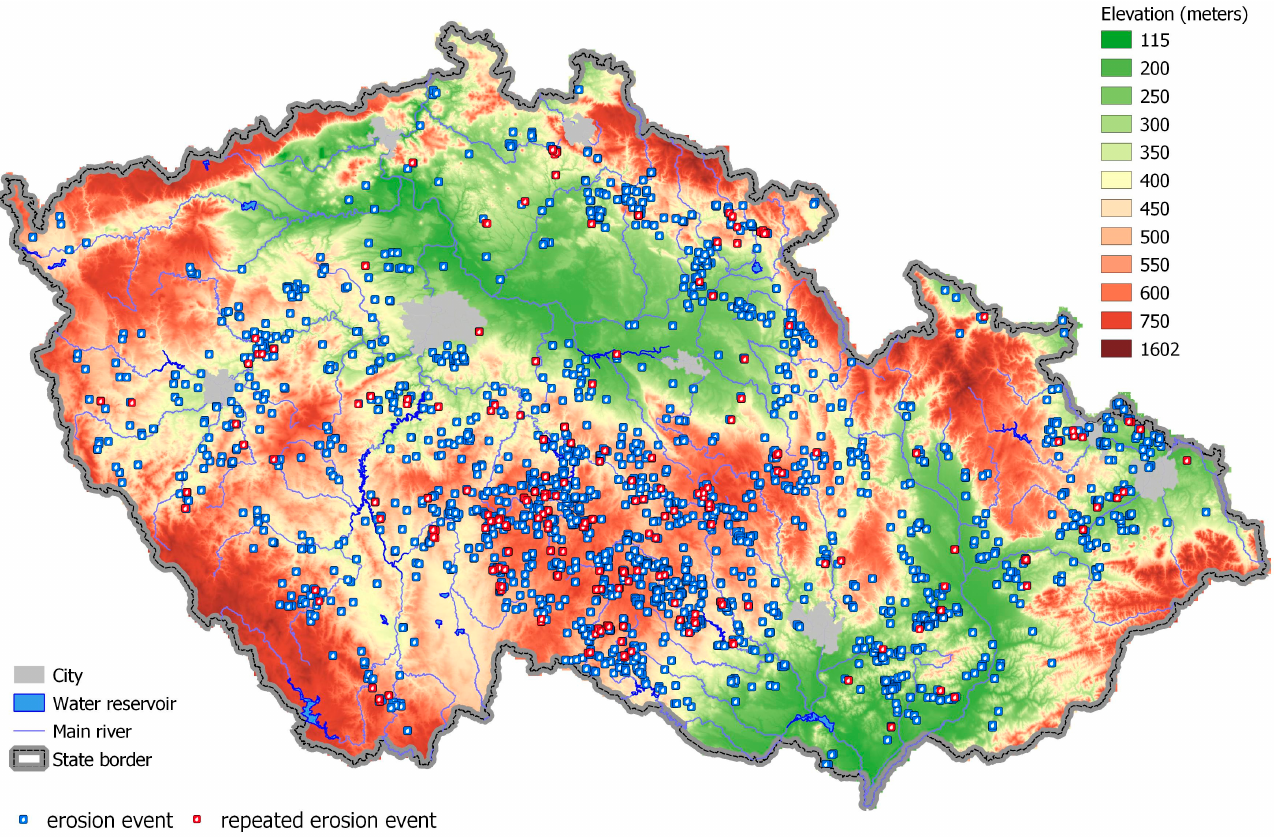
Figure 1. Recorded erosion events in the Czech Republic up to 10 August 2022. Altitudes are given by the system Balt after normalizing.